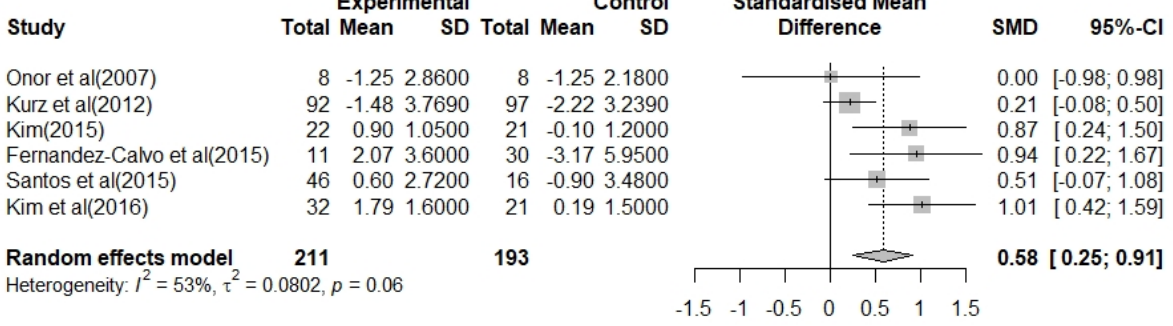
Figure 3. Forest plot for the effects of the multimodal occupational therapy program with cognition- oriented approach on cognitive decline in patients with AD.